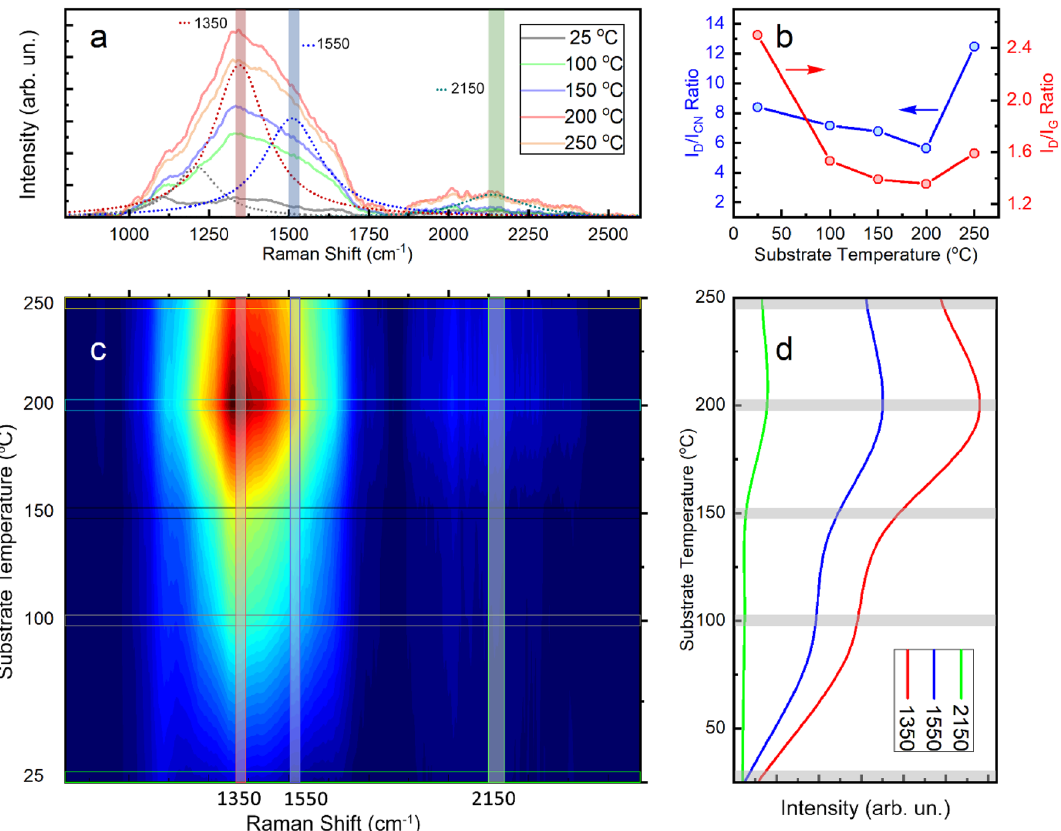
Figure 4. Contour profile Plot for the Raman spectra of the CNx films deposited on glass at different substrate temperatures. ( a ) Overlapping Raman spectra at different deposition temperatures, with deconvolution of the characteristic vibrational peaks (dot lines). ( b ) Variation of I D /I G and I D /I CN ratios as function of substrate temperature. ( c ) Generated contour map for Raman spectra at different temperatures. ( d ) Intensity of the three characteristic vibrational bands ( D @1350 cm −1 , G @1550 cm −1 , and CN @2150 cm −1 ) in CNx films with substrate